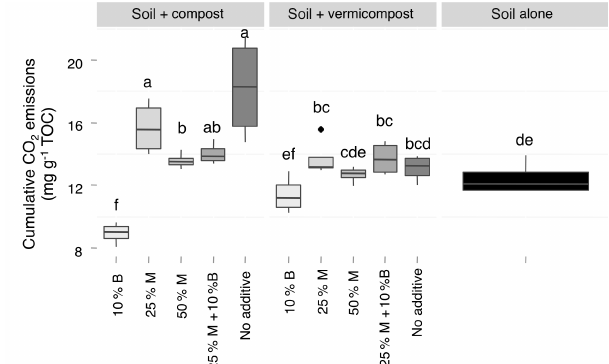
Figure 4. Cumulative CO 2 emissions after 30 days of incubation of the soil alone or amended with composts and vermicomposts with 25% of clay (25%M), 50% of clay (50%M), 10% of biochar (10%B) or 25% of clay and 10% of biochar (25%M + 10%B). Different letters (a, b, c, d, e and f) indicate statistically significant